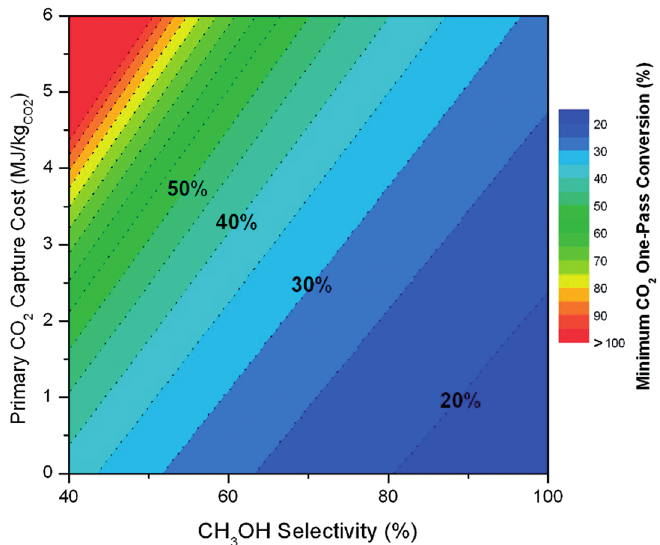
Figure 32. Effect of photocatalyst selectivity and CO 2 capture cost on minimum one-pass conversion for positive energy incorporation efficiency (EIE > 0) (reproduced from [231] with permission of the Royal Society of